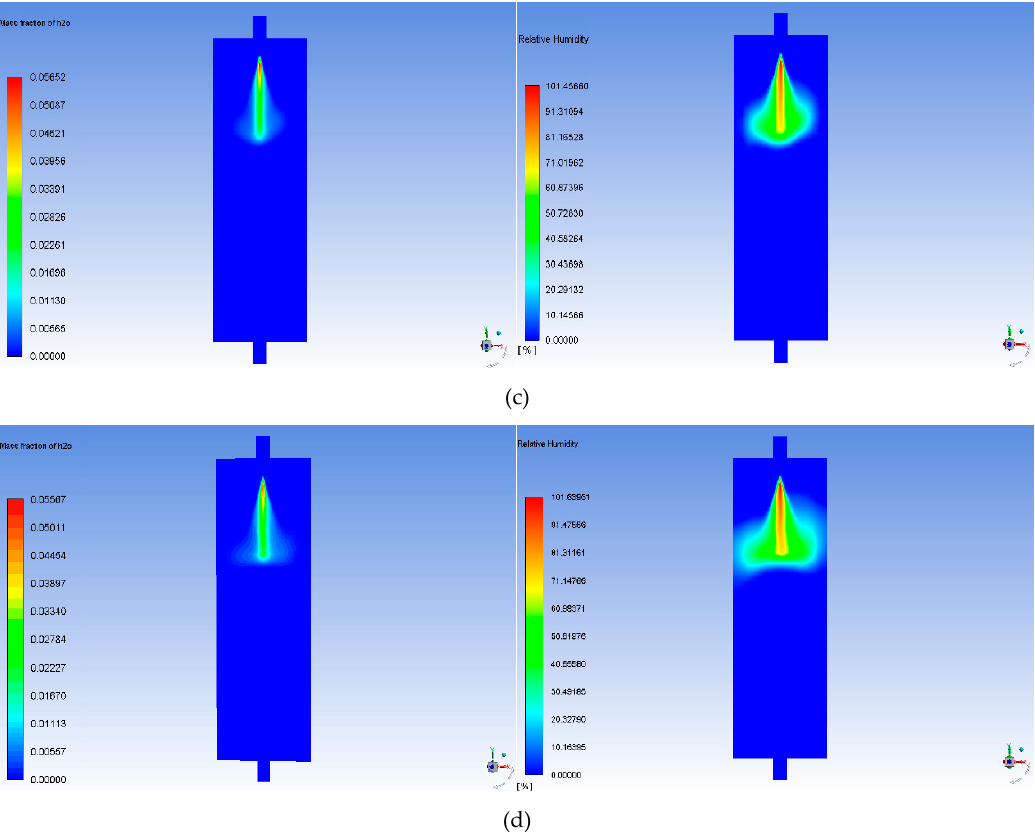
Figure 3. Water vapor mass fraction and relative humidity at the outlet of humidifier at different inlet gas velocity: ( a ) The inlet air velocity is 5 m · s − 1 ; ( b ) the inlet air velocity is 10 m · s − 1 , ( c ) the inlet air velocity is 15 m · s − 1 , ( d ) the inlet air velocity is 20 m · s − 1